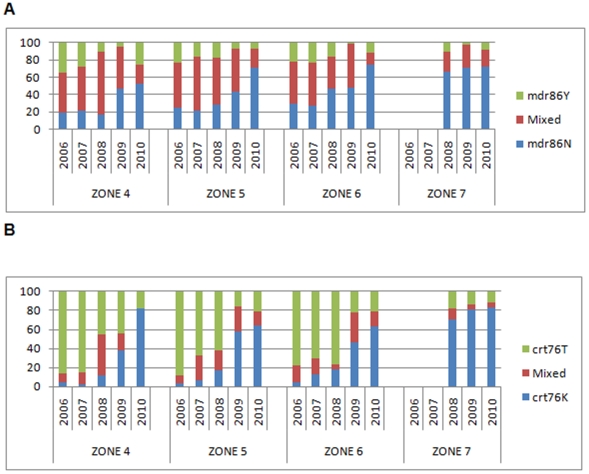
Prevalence of pure wild, pure mutant and mixed crt76 and mdr186 alleles (%) in Gaza Province by Year and Zone.